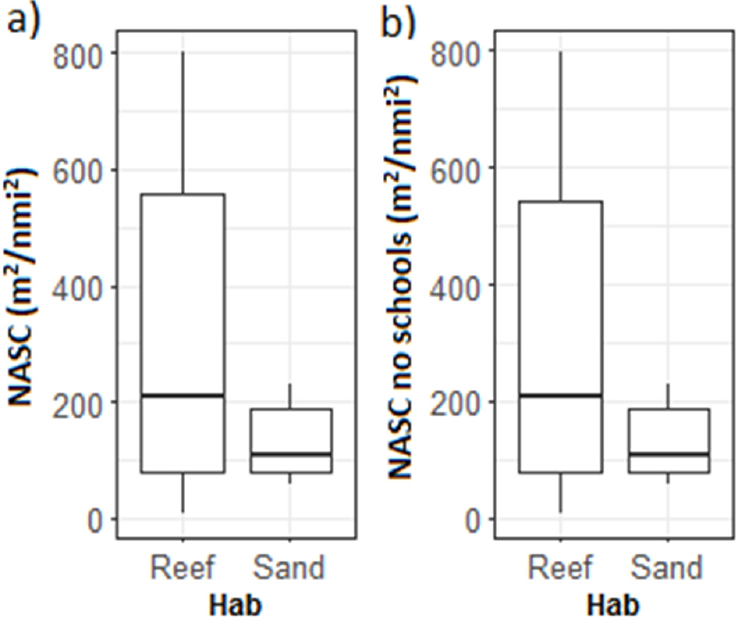
Figure 11. Box plots of the acoustic variables ( a ) NASC BRUV-mean and ( b ) NASC BRUV-mean without schools grouped by benthic habitat observed in the video, excluding 40.5 m of water column above the seafloor.